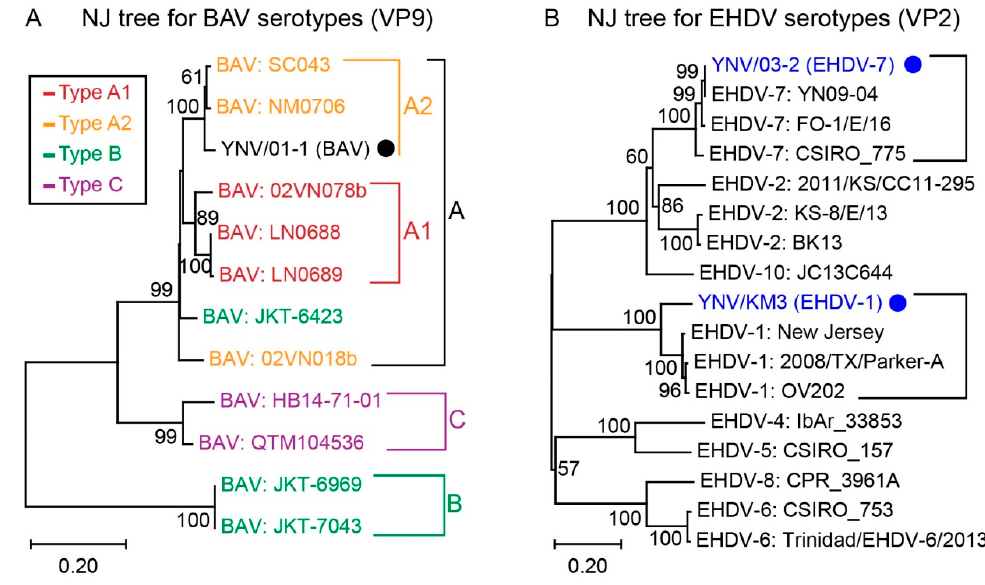
Figure 4. Phylogenetic analysis of BAV genotypes and EHDV serotypes. Phylogenetic trees con- structed by NJ algorithm using complete CDS of BAV VP9 ( A ) and EHDV VP2 ( B ), respectively. Viral species and voucher numbers are provided; novel BAV isolate and EHDV isolates reported in this study are labeled by black solid circle and blue solid circles respectively. Bootstrap values <50% are omitted. In tree (A), previously reported genotypes are highlighted by red (type A1), orange (type A2), green (type B), and violet (type C), respectively.